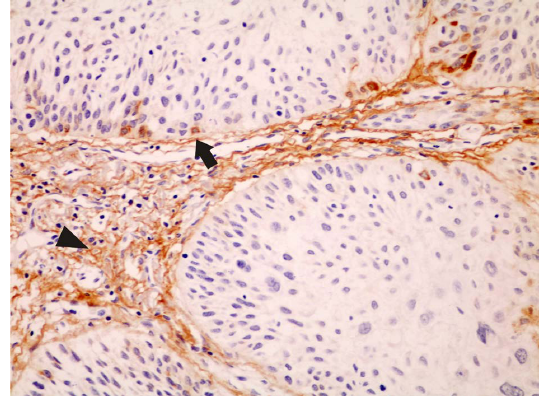
Figure 4. Immunoexpression of tenascin in SCCLi throughout peritumoral basement membrane (arrow) in linear and thin pattern and tumor stroma (arrowhead) (LSAB method, original magnification